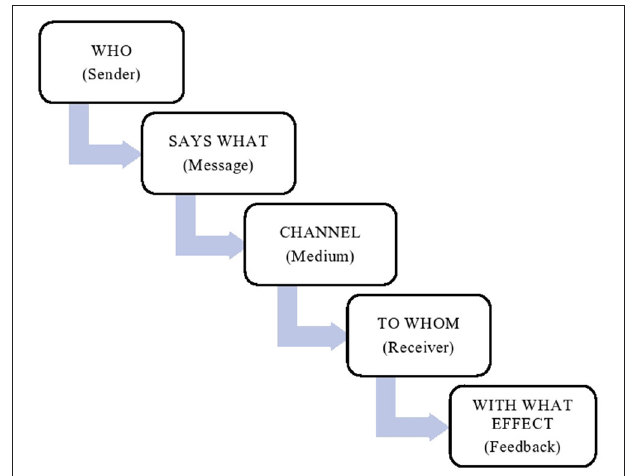
FIGURE 1 | Components of Lasswell’s communication model (8,